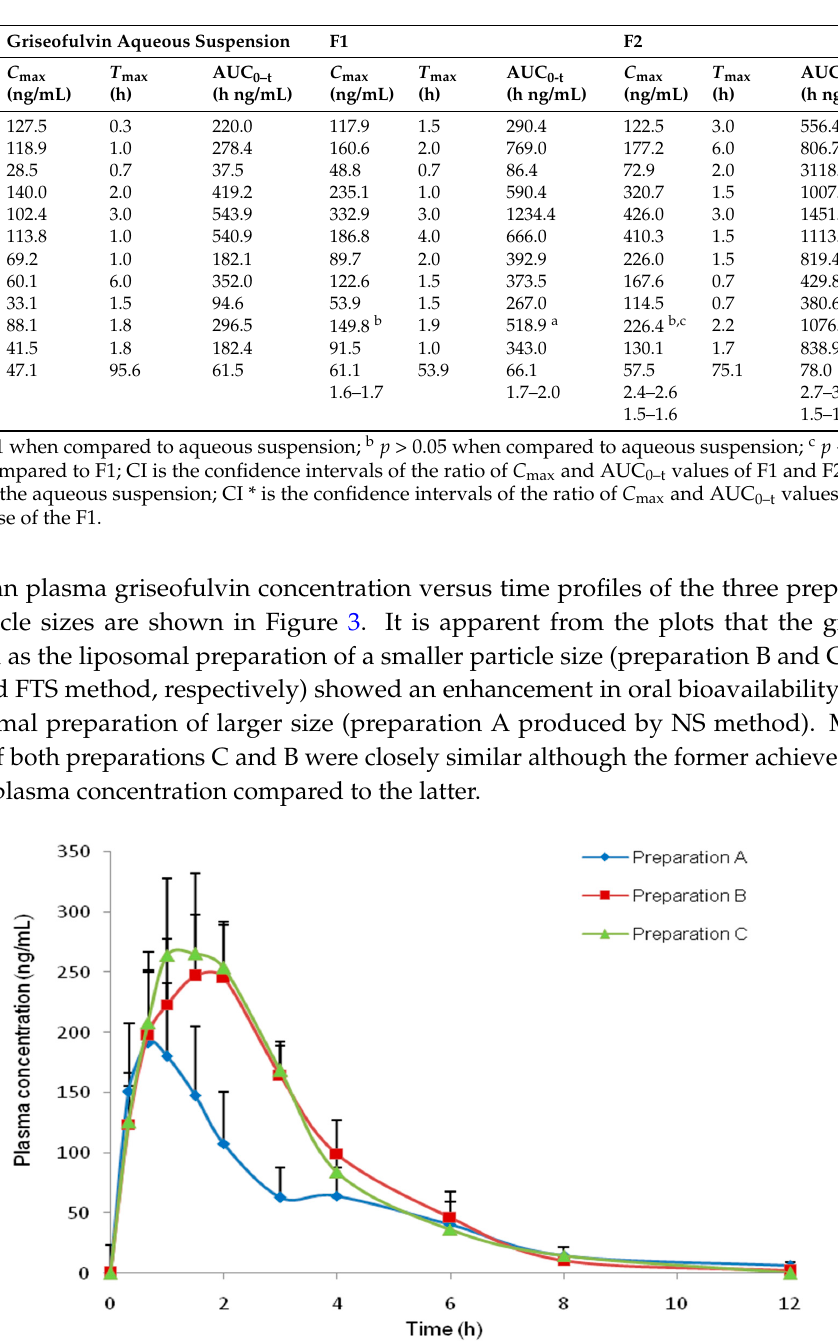
Figure 3. Mean plasma griseofulvin concentration versus time profiles after dosing with liposomal preparations of various particle size (8 mg/kg) (Mean ± SEM, n = 9).